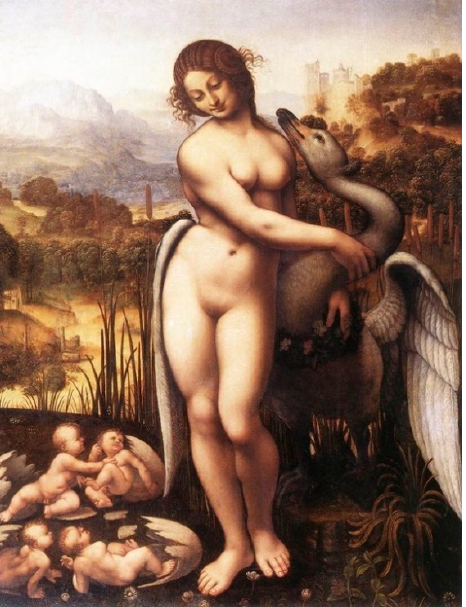
Figure 6. Oil on canvas of Leda and the Swan , a copy by Cesare da Sesto after a lost original by Leo- nardo da Vinci, 1515–1520, © Wilton House,